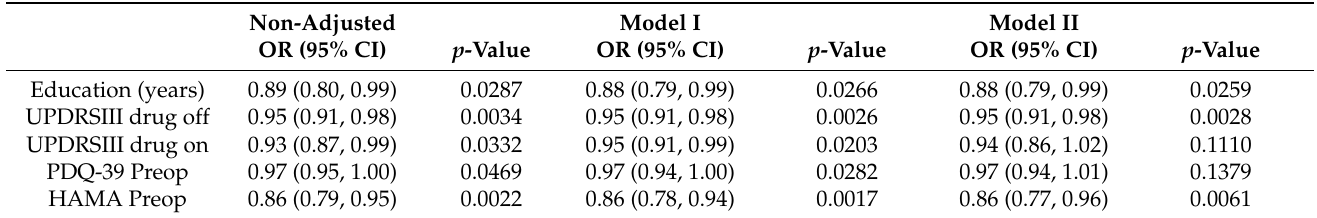
Table 3. Multivariate regression showing the effect of education, UPDRS-III drug on, UPDRS-III drug off, PDQ-39 Preop, and HAMA Preop on the improvement of